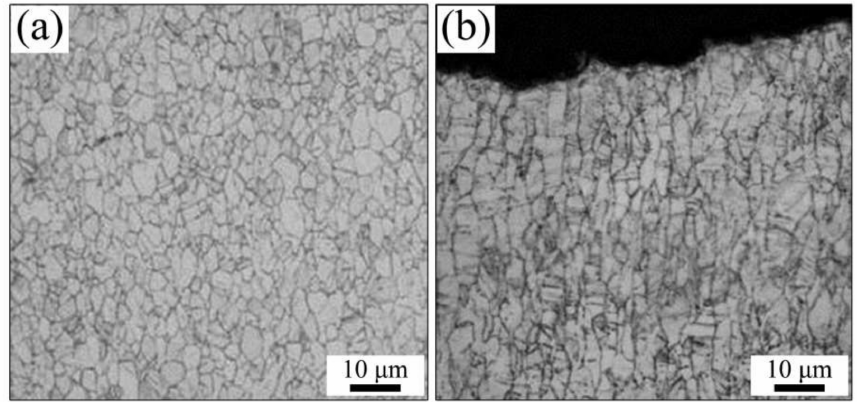
Figure 10. Metallographic observations of the uniform deformation part A ( a ) and necking part B ( b ) indicated by the black point in Figure 11a.